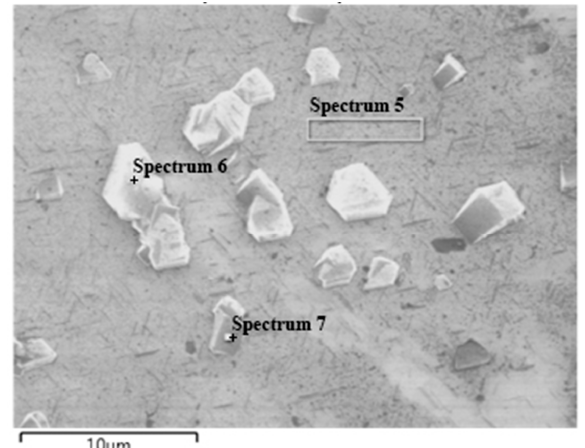
Figure 8. Areas for identifying Sample 2 surface composition.